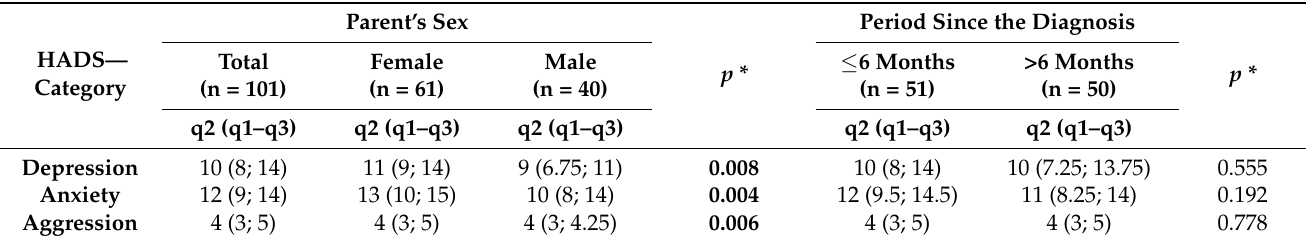
Table 2. The depression, anxiety and aggression scores by parents’ sex and period since the diagnosis of child’s disease.